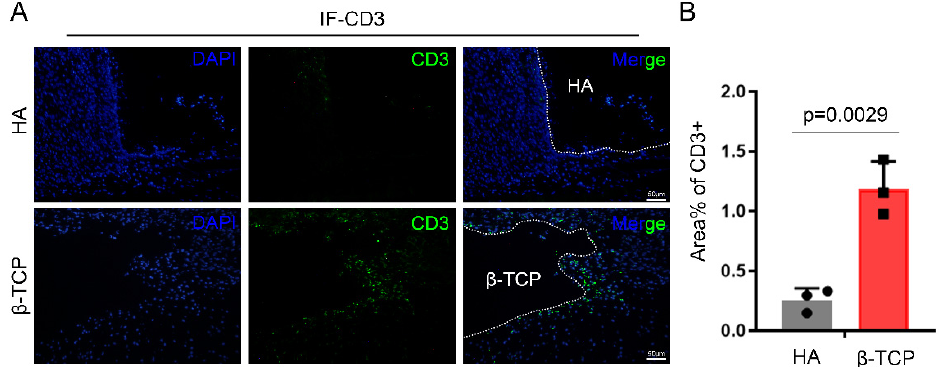
Figure 3. More CD3+ T-cells surrounding β -TCP than HA. ( A ) IHC staining of T-cells marker CD3. ( B ) Semiquantitative comparison of positive expression. n = 3, black circles and blocks represent values from a single sample.